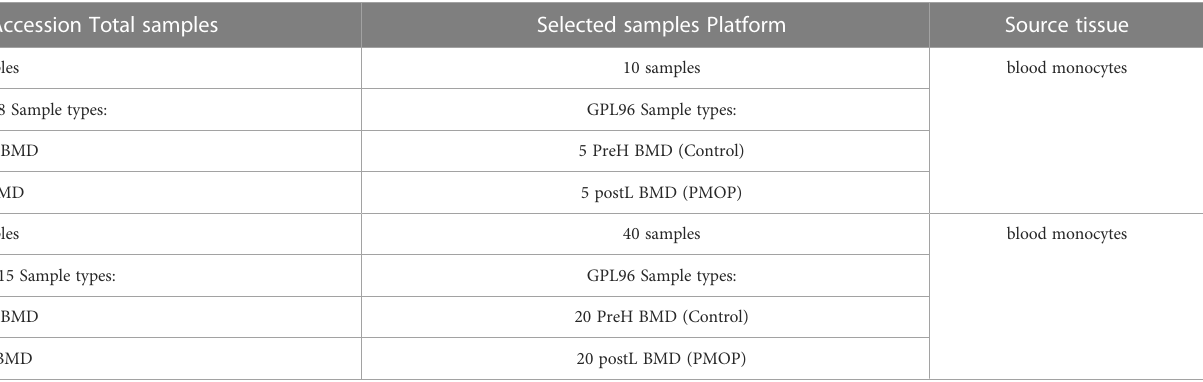
TABLE 1 Information for the selected microarray